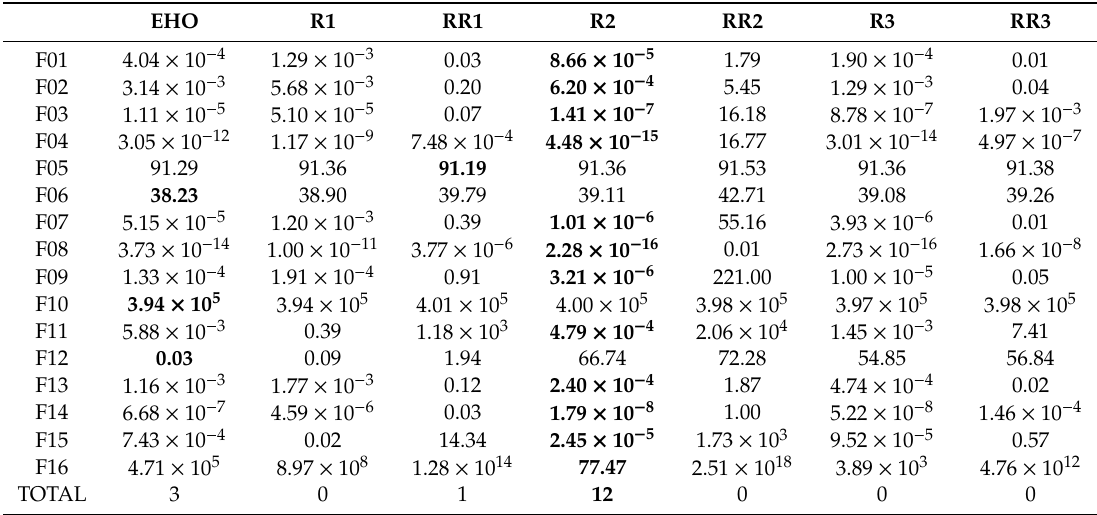
Table 10. Mean function values obtained by EHO and six improved methods with D = 1000.